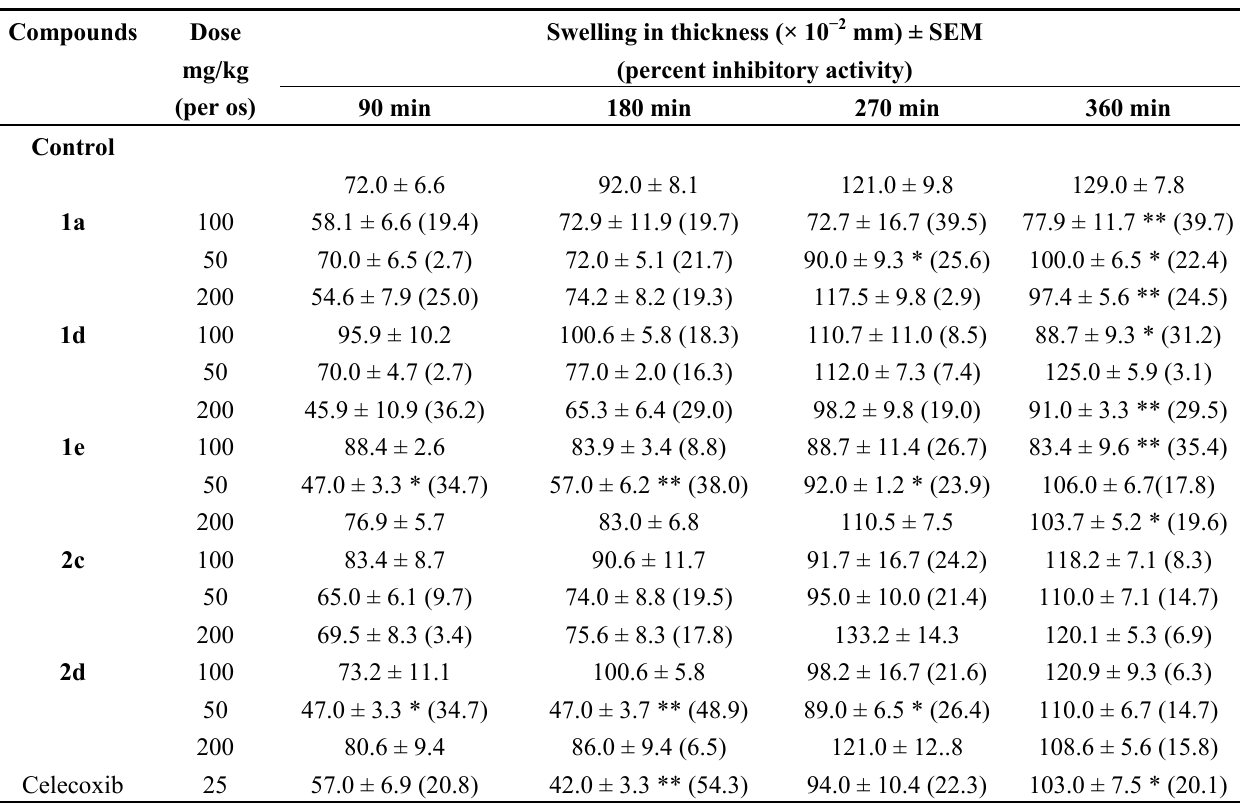
Table 1. Dose-dependent anti-inflammatory effects of the compounds against carrageenan-induced hind paw edema model in mice in different doses.